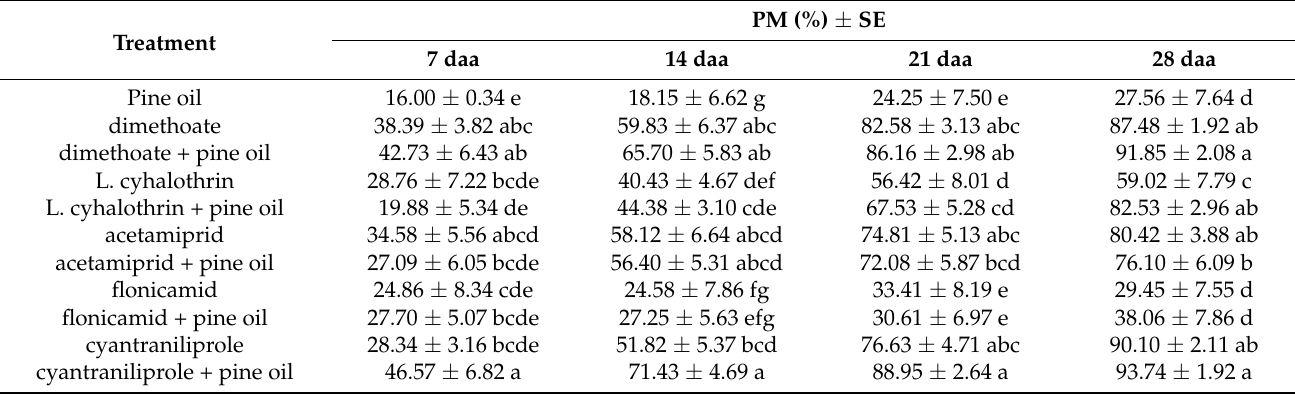
Values with different letters are significantly different among the treatments tested for each assessment period (Fisher’s LSD test, p < 0.05). PM: percentage of corrected mortality; SE: standard error; ns: not significant; daa: days after application; L. cyhalothrin: lambda-cyhalothrin. Individuals expressed as the mean of PM (%) ± (SE) in different assessment timings (7; 14; 21 and 28